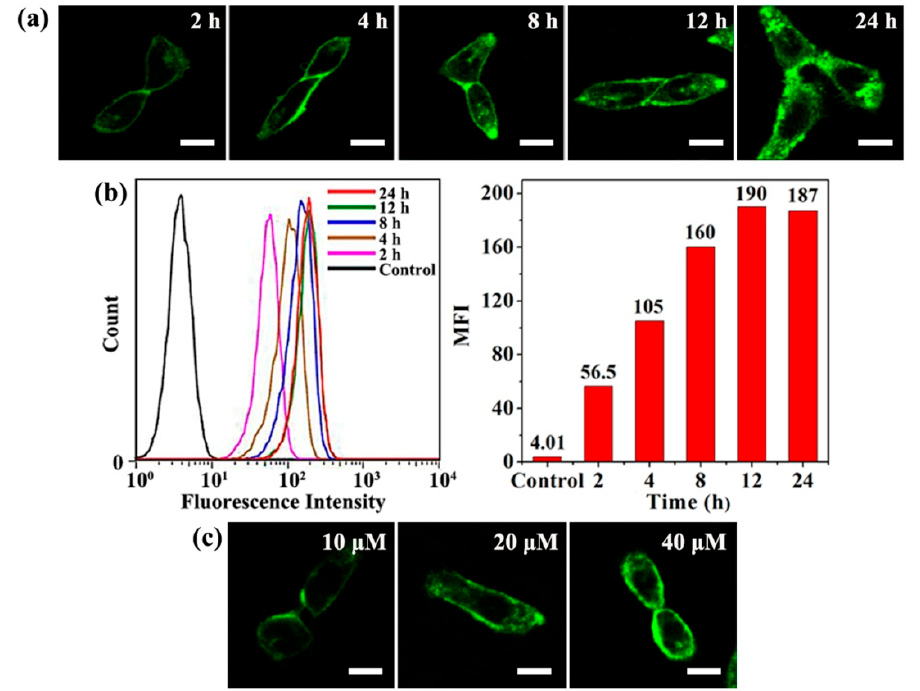
Figure 5. ( a ) Confocal laser scanning microscope (CLSM) images of HeLa cells treated with AIE-M (20 μ M) for different incubation time; ( b ) Flow cytometry analyses of HeLa cells incubated with AIE-M for various incubation time; ( c ) CLSM images of HeLa cells incubated with 10 μ M, 20 μ M and 40 μ M AIE-M for 4 h. The scale bar is 20 μ m.